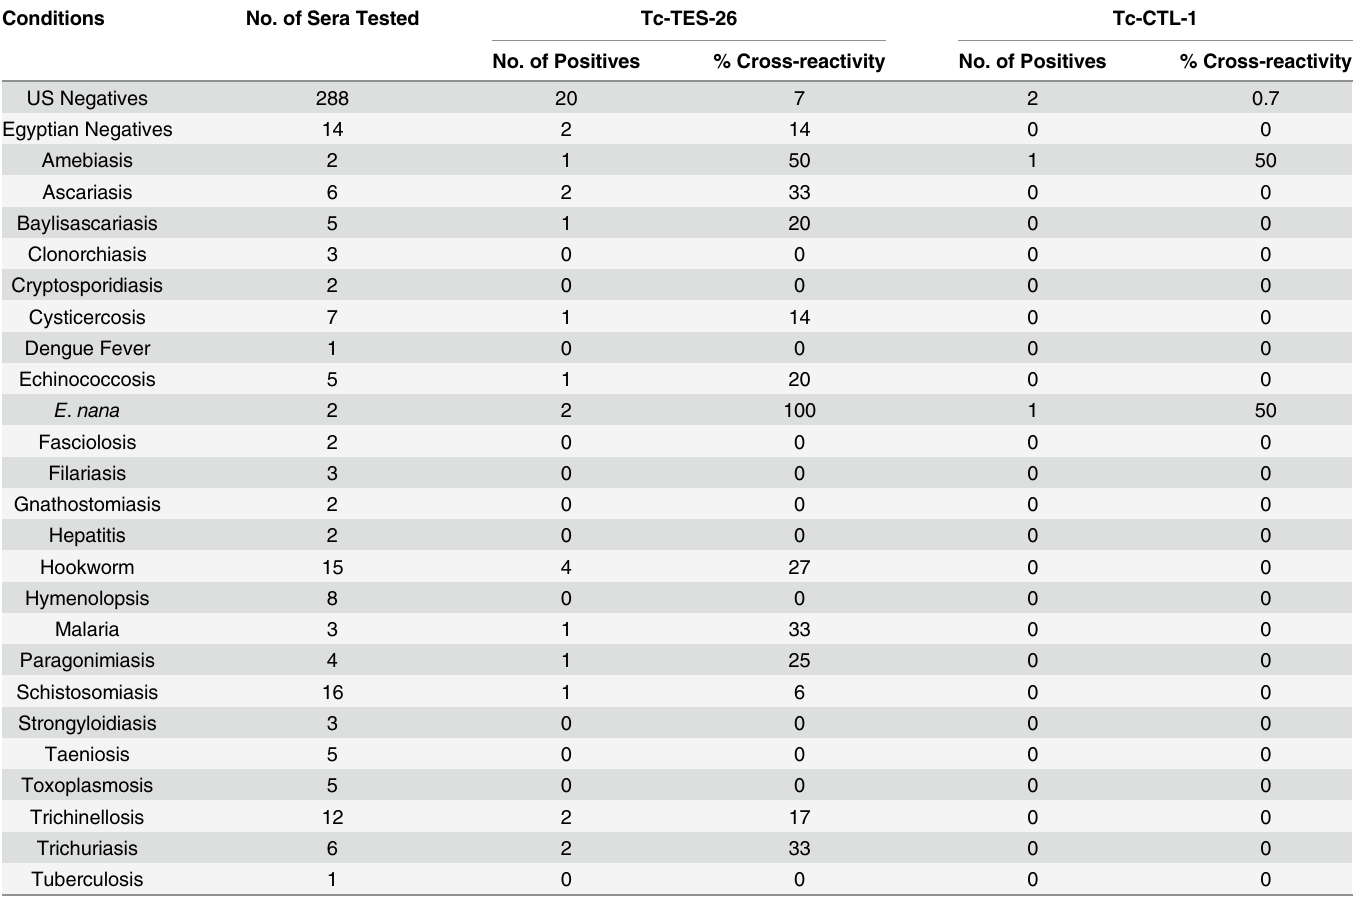
Table 4. Specificity of the Toxocariasis Luminex assay.